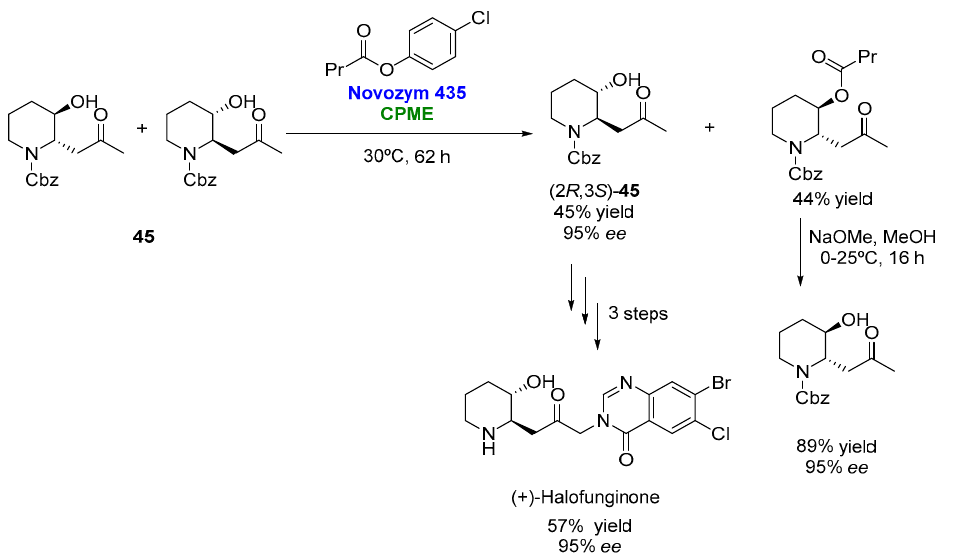
Figure 23. Chemoenzymatic synthesis of (+)-halofunginone employing CPME for the biocatalyzed kinetic resolution.